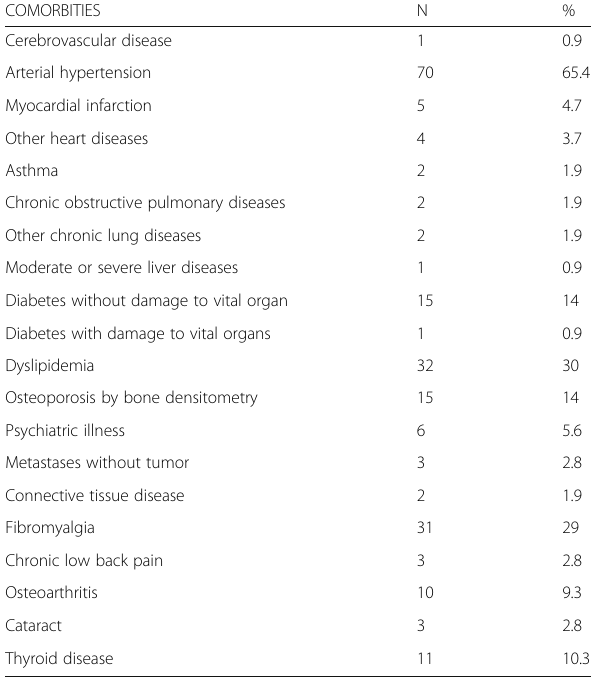
Table 1 (abstract P125). Comorbidities in patients with RA